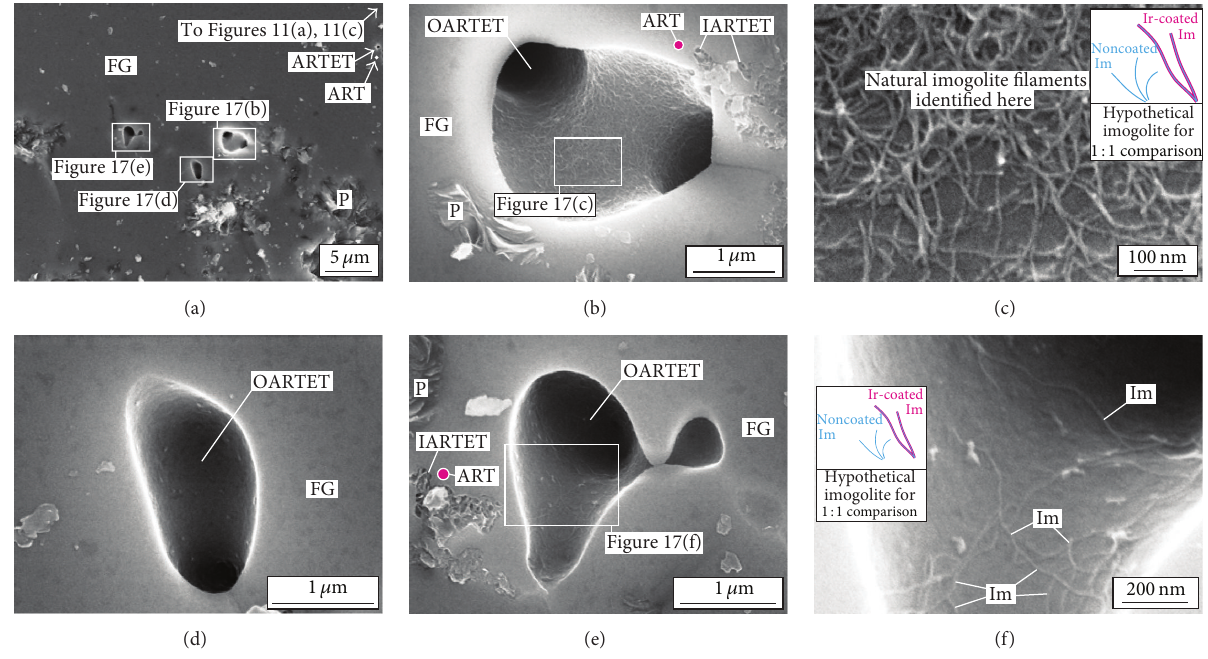
Figure 17: Examples of a peculiar class of etch-tunnels at the glass-palagonite interface that formed either by (i) prolonged overetching of alpha-recoil track etch-tunnels (i.e., are overetched ARTETs or “OARTETs”) and/or (ii) by the advance of etch-tunnelling primarily through pressure solution (caused by increasing hydrostatic pressure through time: Figure 16). All images (a–f) are SEM (secondary electron) images, obtained from the freshly fractured surface of a basaltic glass “chip sample” from DSDP-418A-75-3[120–123] . Regardless of their origin, these etch-tunnels contain authigenic imogolite filaments within them (c, f) (similar in nature to the imogolite filaments found within ARTETs— see Figure 12), which seems to indicate possible links with alpha-recoil track etch-tunnelling. Note that the etch-tunnels in this region (a) actually occur along the same glass-palagonite interface and etch-tunnel zone shown in Figure 11 (which contains both FTETs and ARTETs) and occur nearby to some ARTETs (e.g., see ARTET at top right in (a)). Furthermore, some of the alteration features in the immediate vicinity of these tunnels are close to the same size as an alpha-recoil track ( ∼ 120nm) and are therefore interpreted as corroded or “infilled ARTETs” (see “IARTETs” at top right in (b) and at left in (e)). Although these comparatively large etch-tunnels (a, b, d, e) are closer in size to